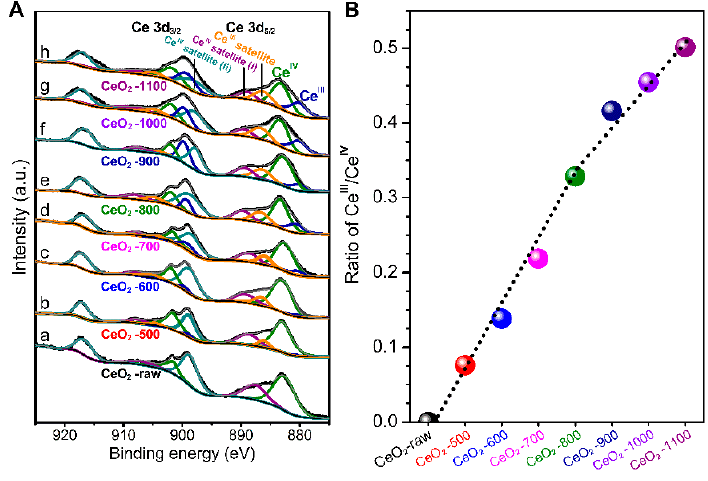
Figure 3. ( A ) Ce 3d X-ray photoelectron spectroscopy (XPS) spectra, and ( B ) the relatively intensity ratios of Ce III / Ce IV of CeO 2 -raw and CeO 2 -x.